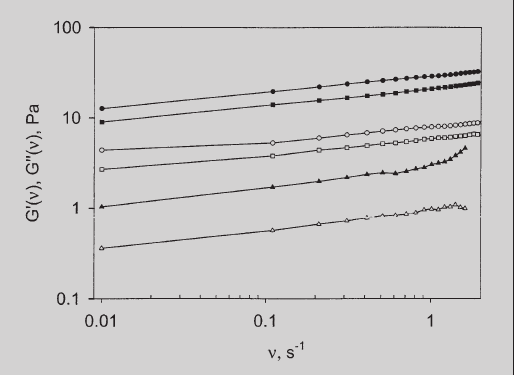
Figure 4 (left): The mechanically measured frequency dependent storage G’( ν ) (solid symbols) and loss G’’( ν ) (open sym- bols) moduli in AMG pre- pared from skimmed milk with different added amounts of GDL: